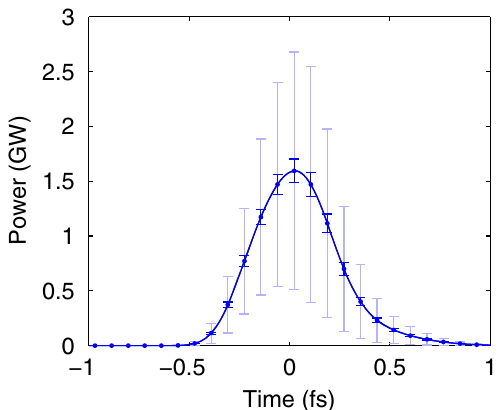
FIG. 11. Mean power at 17.7 m calculated over 100 shot-noise seeds. Bold error bars show the error on the mean value; faint error bars show standard deviation.